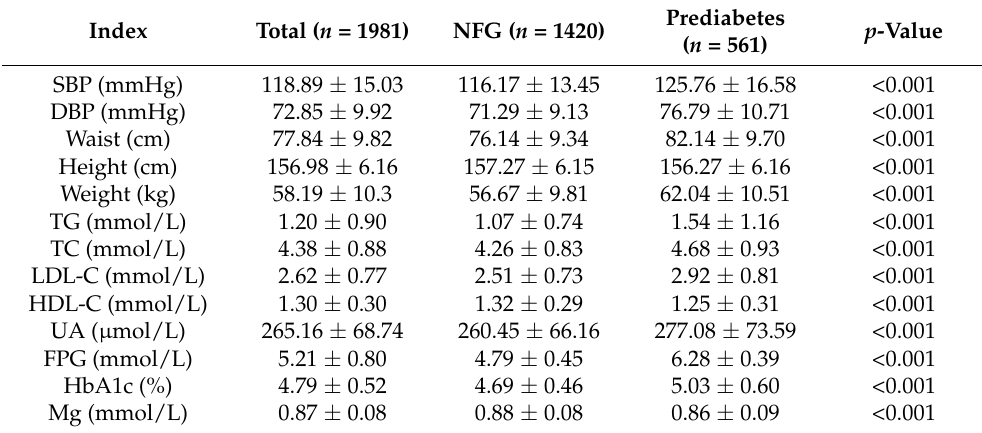
Table 2. Clinical characteristics of NFG and Prediabetes Participants (Mean ± SD).